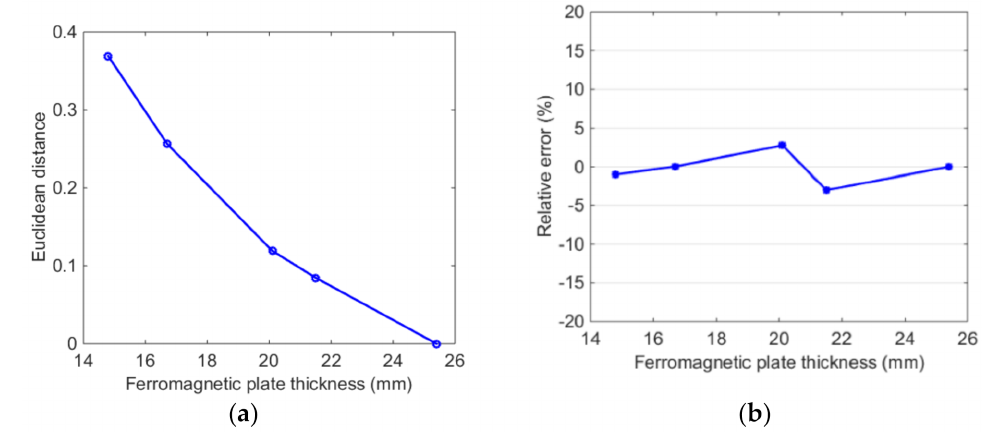
Figure 5. Experiment results: ( a ) Euclidean distances. ( b ) relative error of analytical calculations to